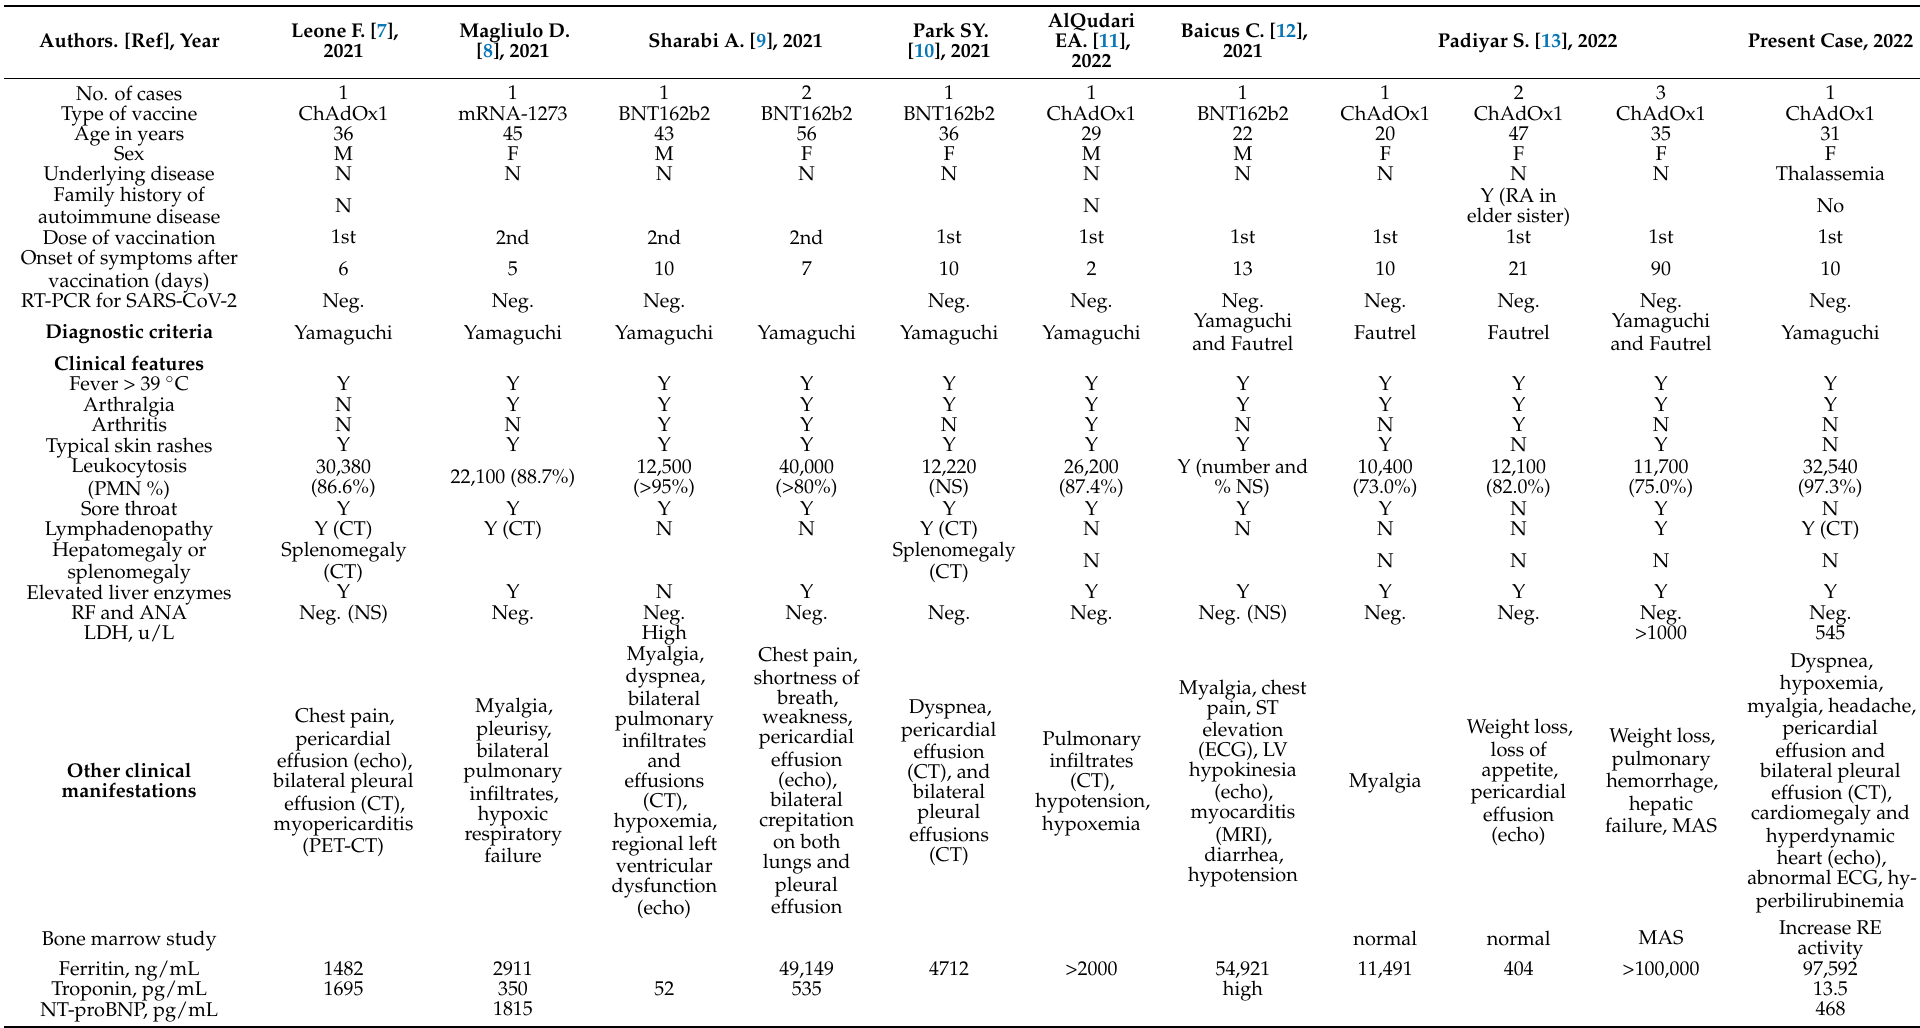
Table 1. Characteristics of adult-onset Still’s disease-like syndrome associated with COVID-19